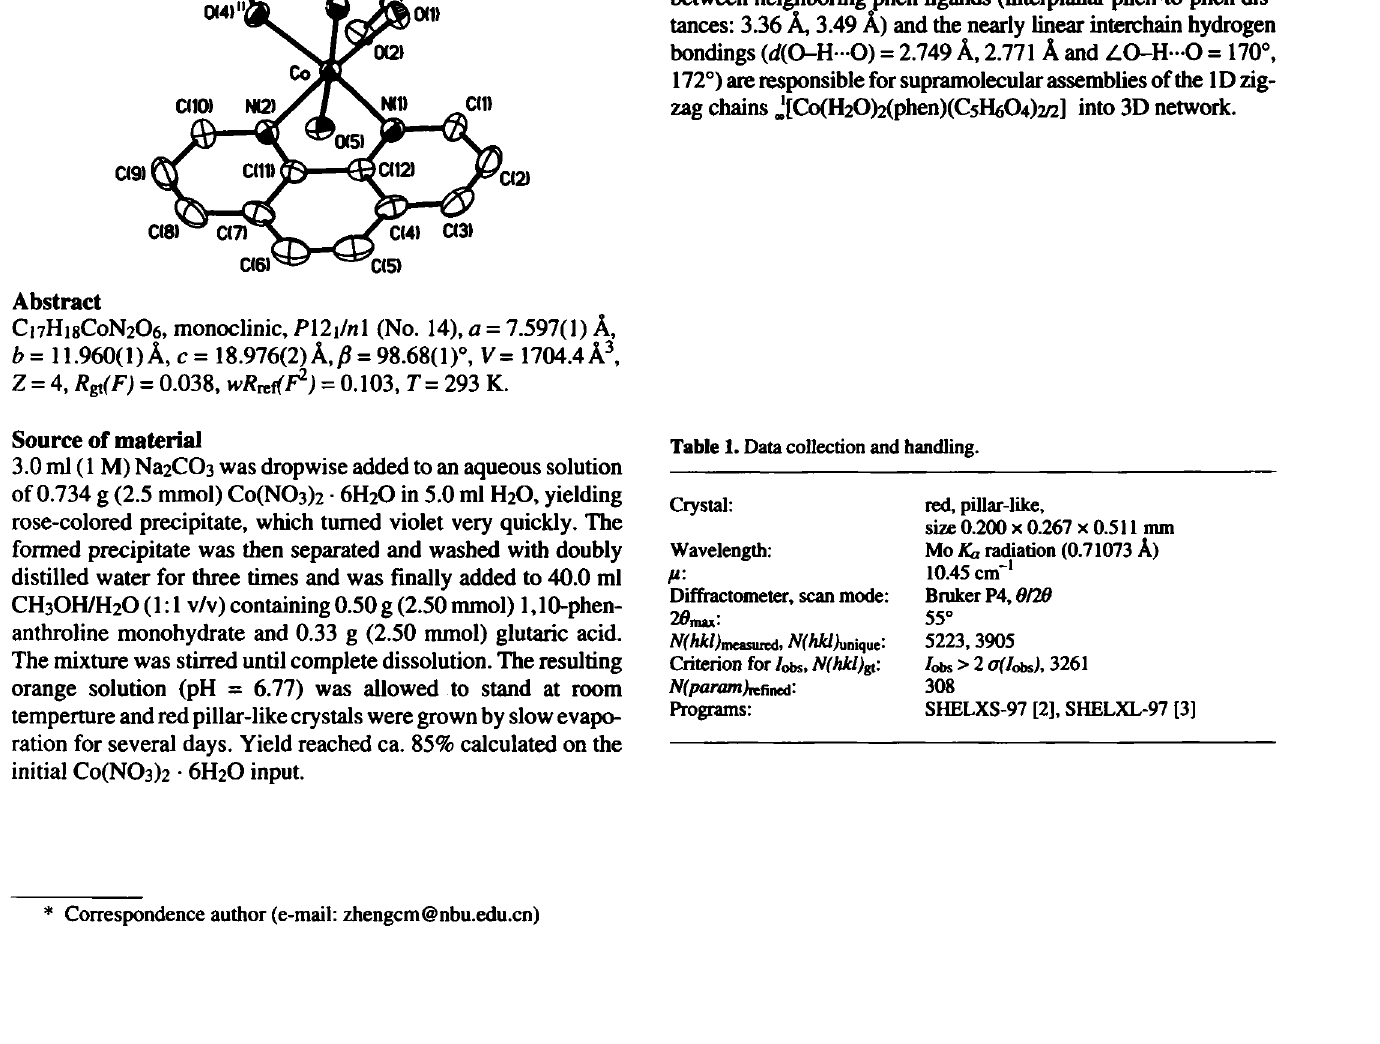
backbone C atoms due to formation of the strong intrachain hy- drogen bonds between water O atom and the noncoordinating